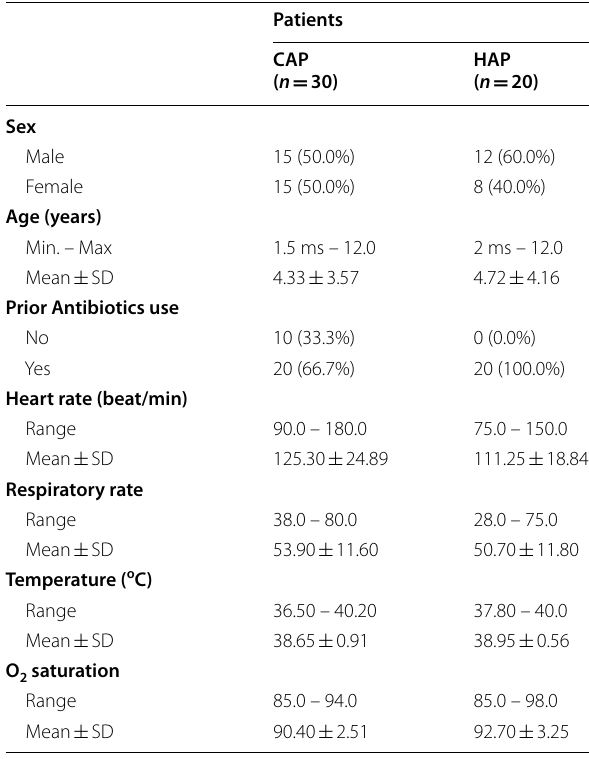
Table 1 Demographic and clinical characterstics of Egyptian children with pneumonia